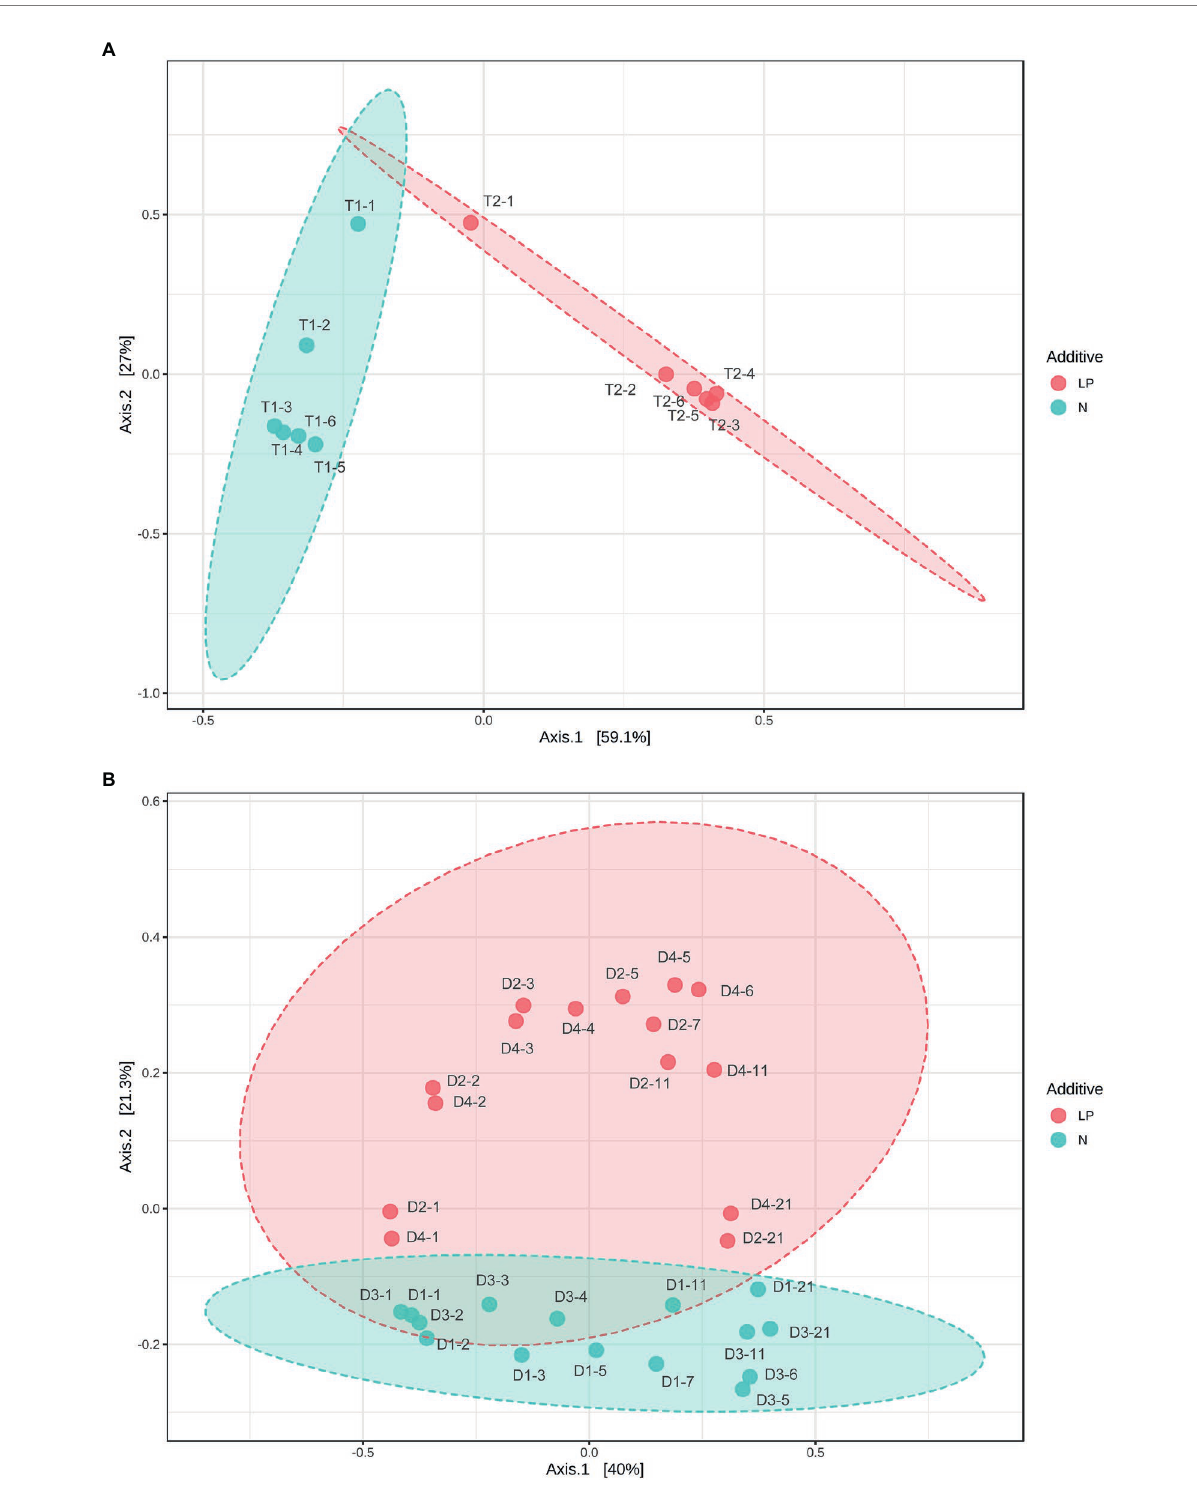
FIGURE 5 Bray–Curtis principal coordinate analysis (PCoA) of indigo fermentation using T- sukumo (A) and D- sukumo (B) . Branch numbers indicate the number of days of fermentation. (A) Indigofera tinctoria L. leaf powder (LP) added (T2: red circles) and control (T1: blue circles). (B) s L. leaf powder (LP) added (D2 and D4: red circles) and controls (D1 and D3: blue circles). Wheat bran was added to batches D3 and D4 on day